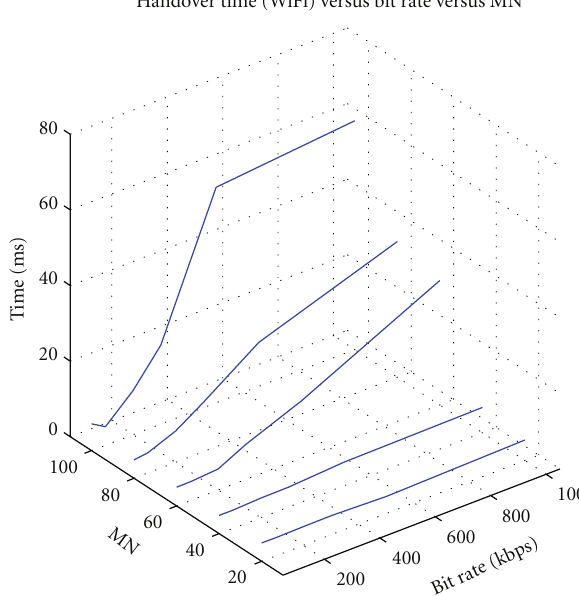
Figure 15: HO time (Wi-Fi) versus bit rate versus no. of MNs.